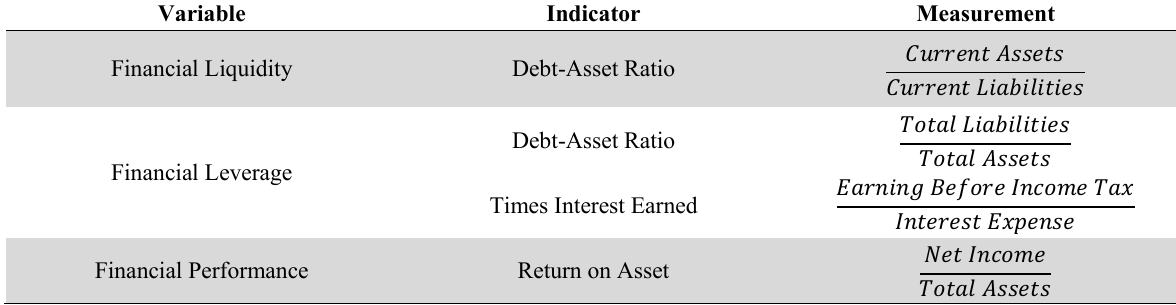
Definitions of variables used in this